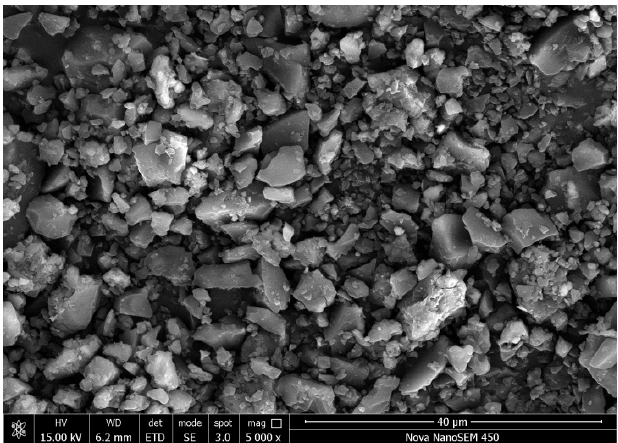
Figure 10. 5000× SEM image of dry coal powder.